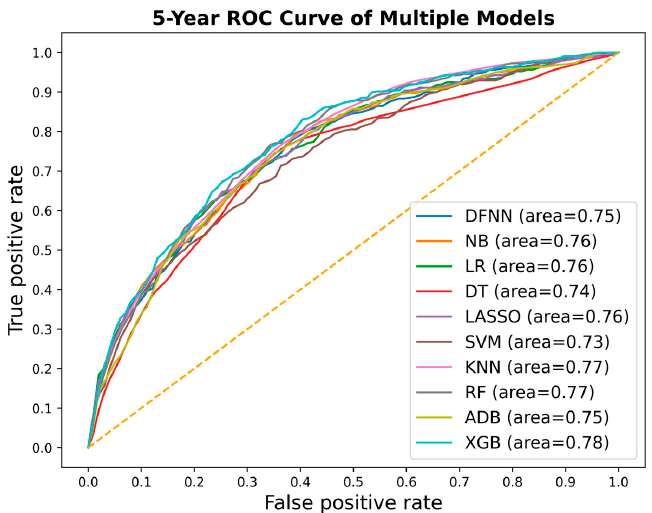
Figure 2. ROC curves of the best-performing models for all methods, each respectively, for predict-